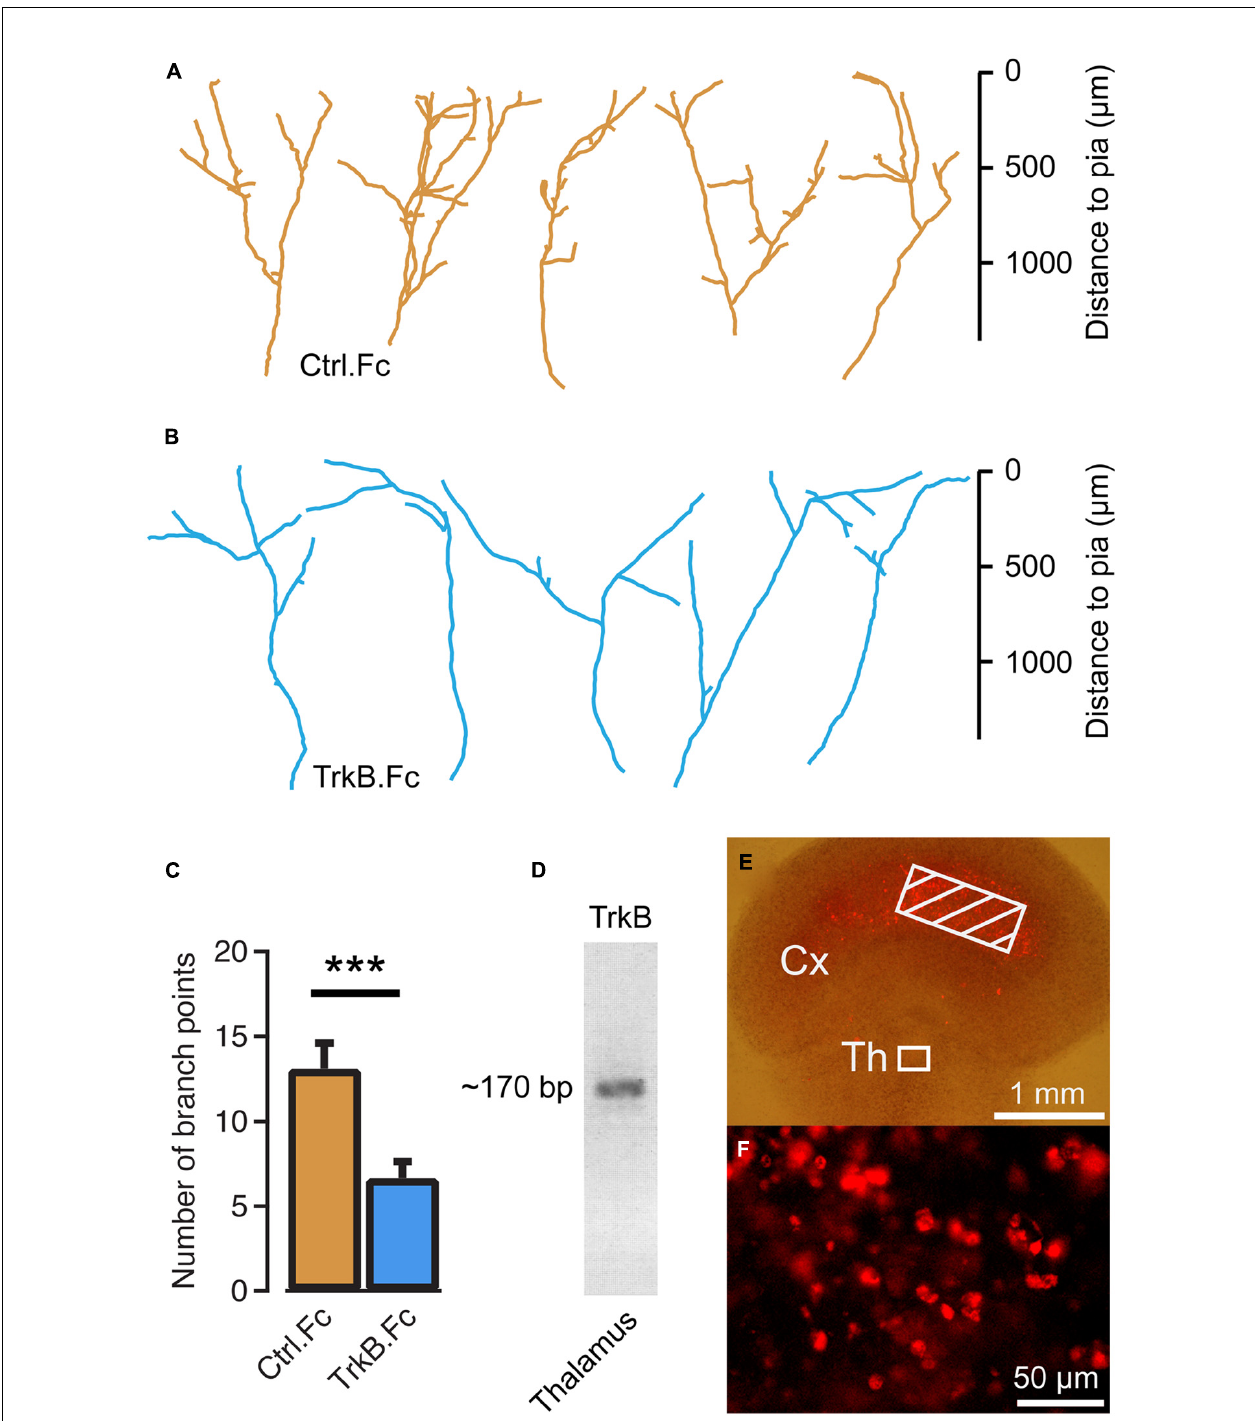
FIGURE 2 | Endogenous brain-derived neurotrophic factor (BDNF) supports thalamocortical axon branching. (A ) Reconstructions of representative axons in thalamocortical co-cultures treated with the Fc region of human IgG. Note the similar morphology to untreated controls in Figure 1E . (B) Reconstructions of representative thalamocortical axons when TrkB.Fc was added to the culture to remove endogenously produced BDNF. (C) Bar diagram for average number of branch points for TrkB.Fc